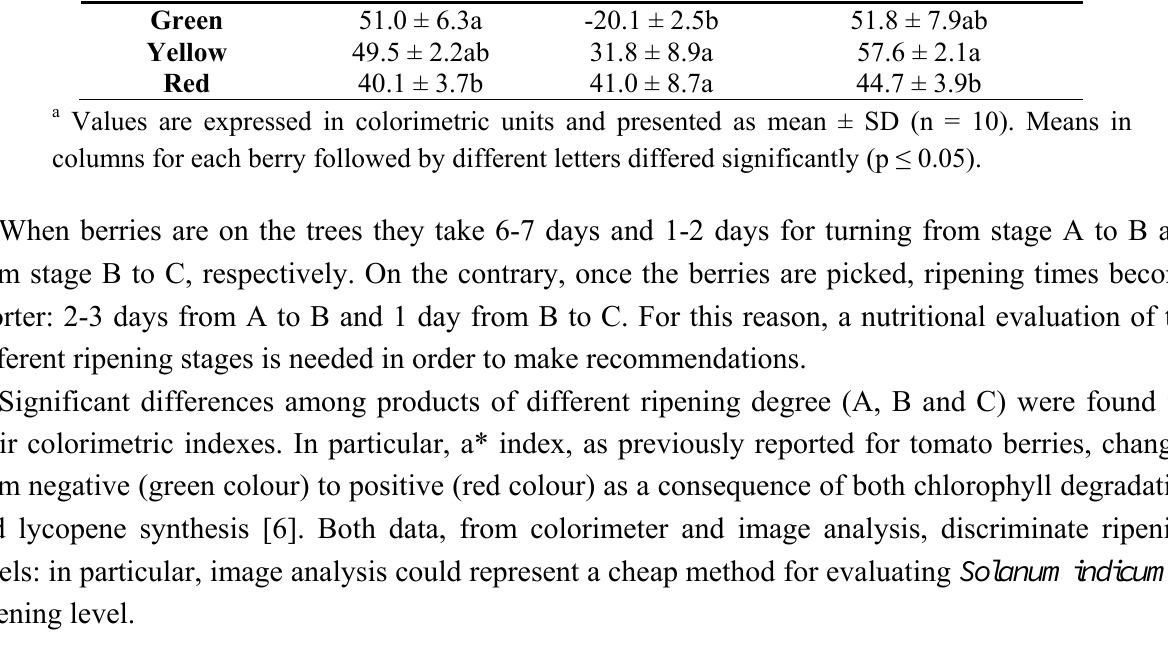
Table 2. Ascorbic acid, α -carotene, β -carotene and lycopene content of Solanum indicum L. at different maturation stages.